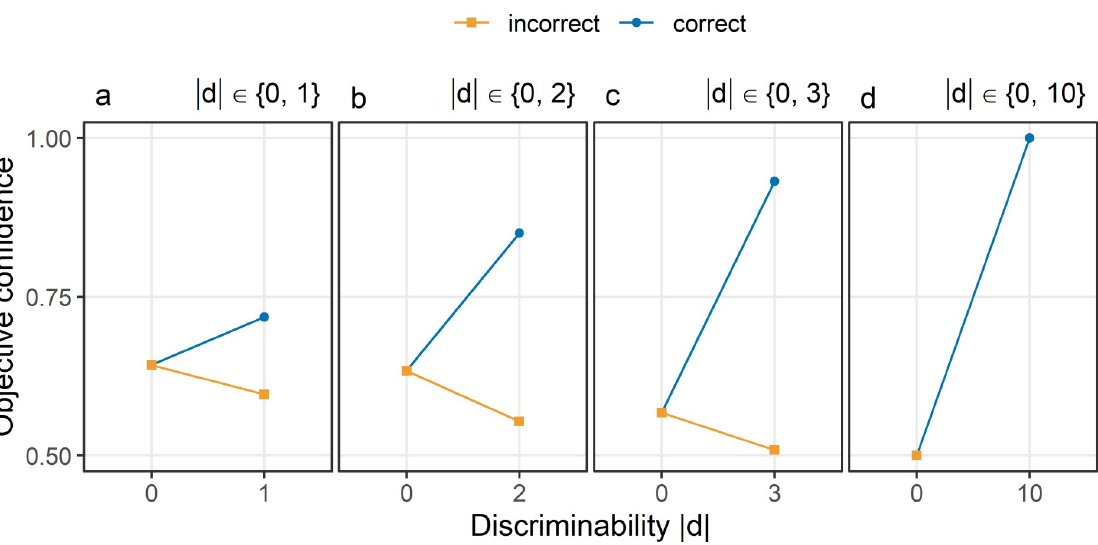
Fig 5. Objective confidence in the standard model if discriminability is either 0 or maximal. Discriminability |d| was always sampled from discrete uniform distributions with only two values. One of the two possible values was always 0, indicating neutral stimuli with respect to the choice options. The second possible value of |d| was 1 (Panel a), 2 (Panel b), 3 (Panel c), or 10 (Panel d). Confidence (y-axis) is shown as a function of discriminability (x-axis) in correct choices (blue) and incorrect choices (orange). The percept e I was sampled from a normal distribution with a mean equal to the stimulus d and a standard deviation σ I of